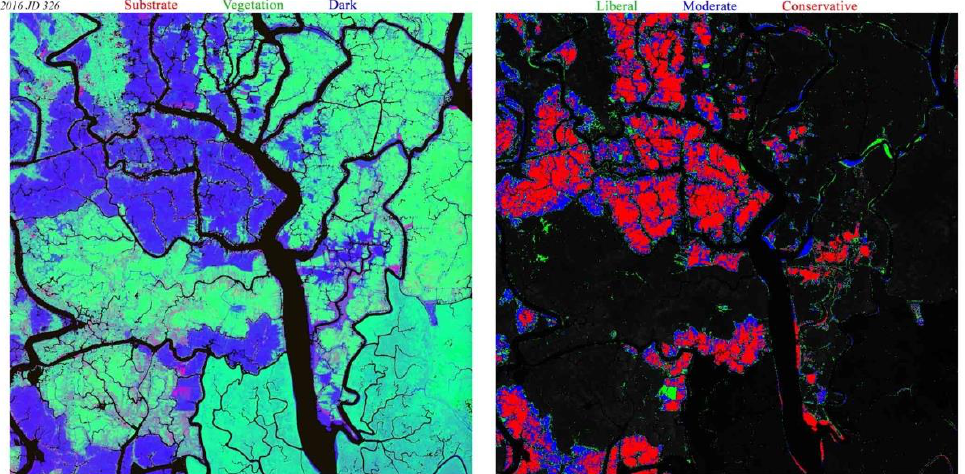
Figure 10. Effect of thresholding Landsat dark fraction imagery using a range of values. Landsat endmember fraction image (left, false color composite: red = substrate fraction; green = vegetation fraction; blue = dark fraction) is thresholded using dark fraction values of 0.80, 0.85, and 0.90, corresponding to liberal, moderate, and conservative thresholds, respectively. Extent and spatial configuration of classified pixels varies substantially based on choice of decision boundary (right, false color composite: red = conservative; blue = moderate; green = conservative threshold). In addition, smaller contiguous areas clearly have lower confidence than larger, spatially homogenous regions of extensive aquaculture.